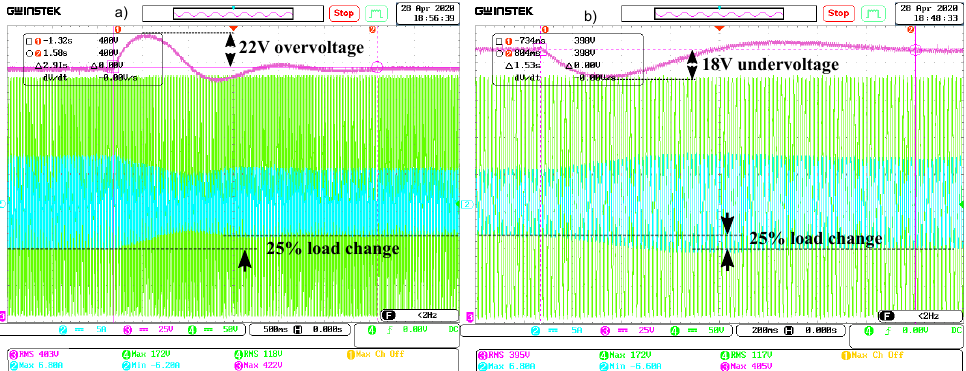
Figure 19. Experimental results with PI-SMC control for load changes: ( a ) load decreases 25%; and ( b ) load increases 25%.